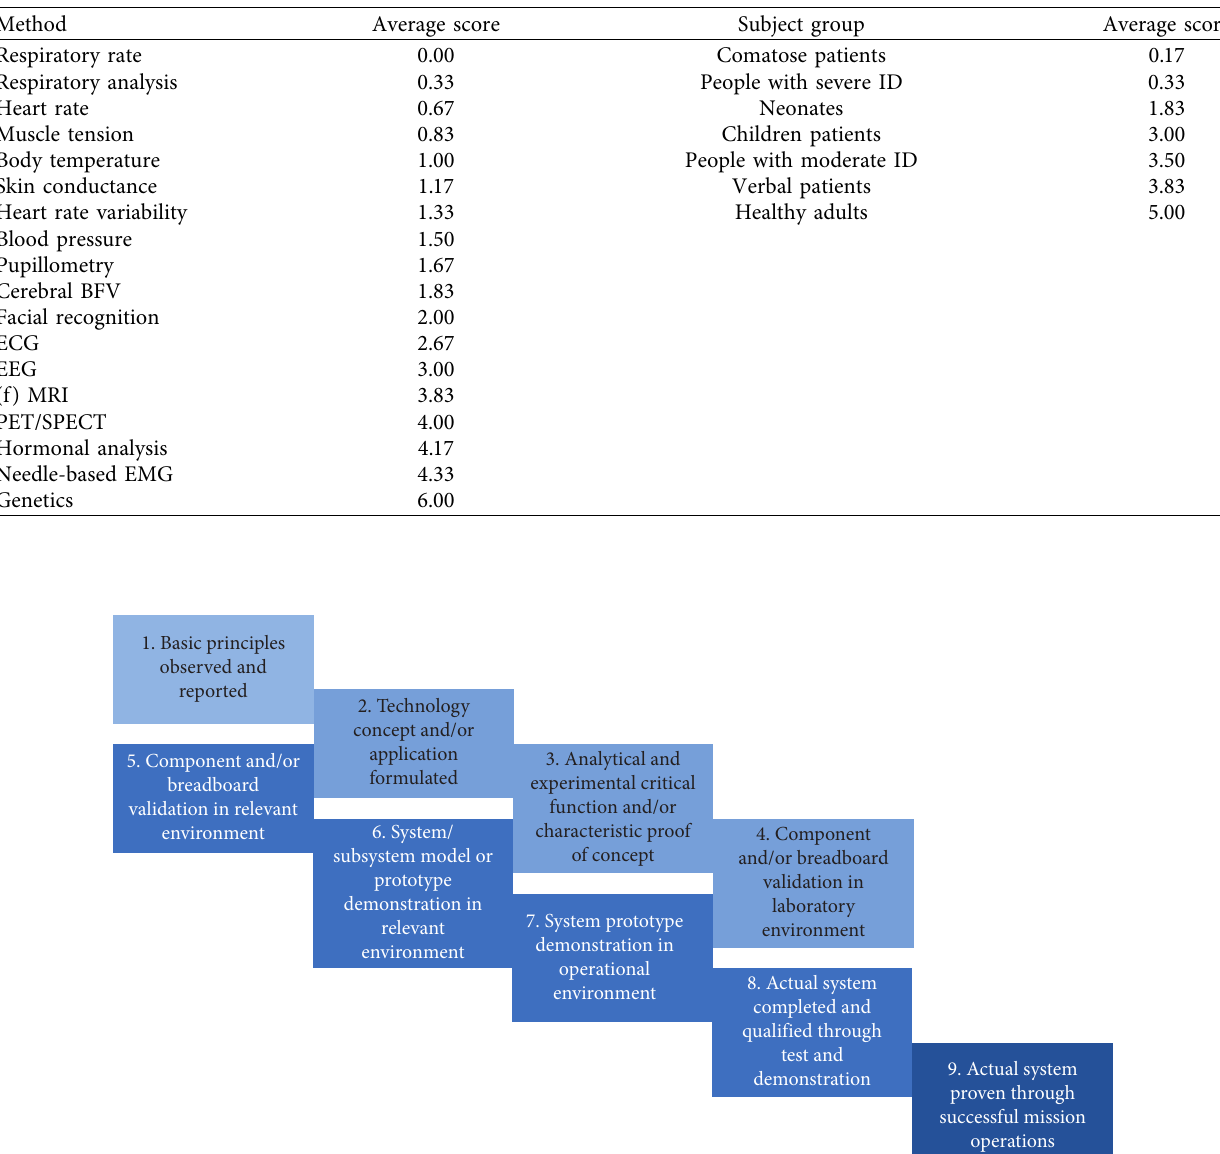
Table 3: Average scores for invasiveness of modalities (left side of the table) and vulnerability of subject groups (right side of the table).